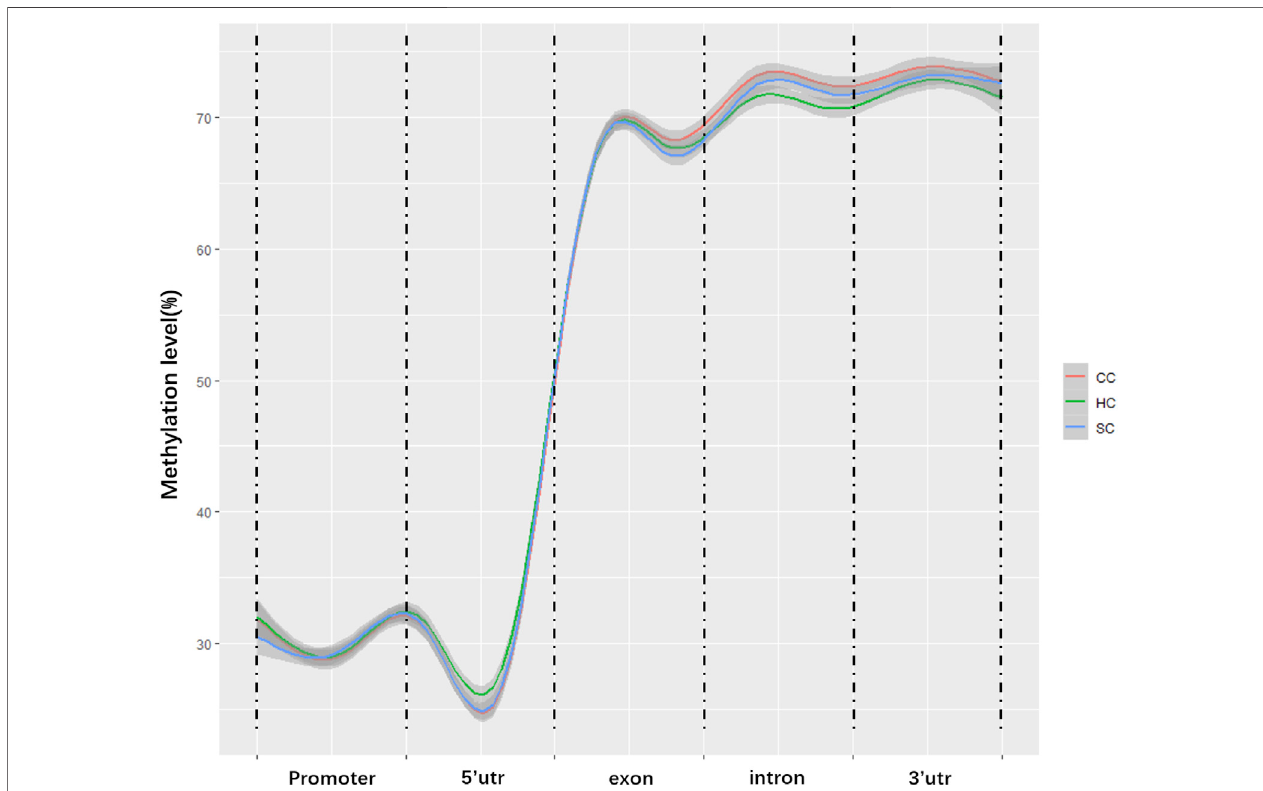
FIGURE1| Averagemethylation levels indifferentgenomicregions. The y -axis isthe methylation level; the x -axis isthe different regions inthe genome. CC: clinical cow; SC: subclinical cow; and HC: healthy cow.